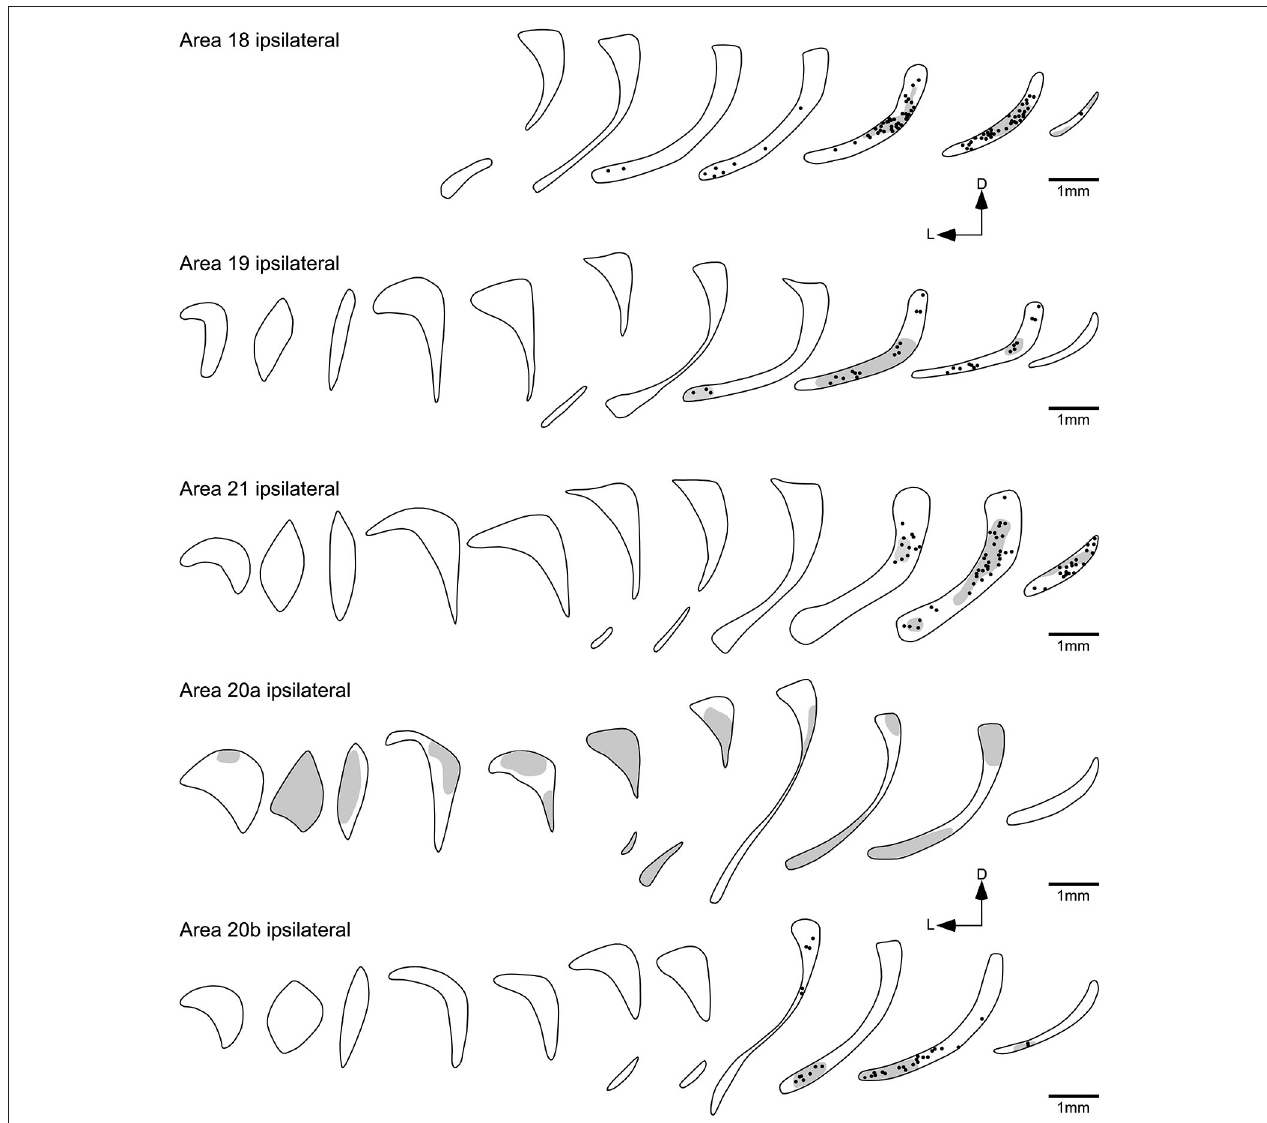
the right and dorsal to the top. In each figurine, the dots represent retrogradely labeled neurons, while the shading represents regions of labeled anterograde axonal terminals. Note the caudally located reciprocal connectivity of the occipital (18, 19, 21) visual areas and also the temporal visual area 20b, while temporal visual area 20a shows a widespread anterograde connectivity to the